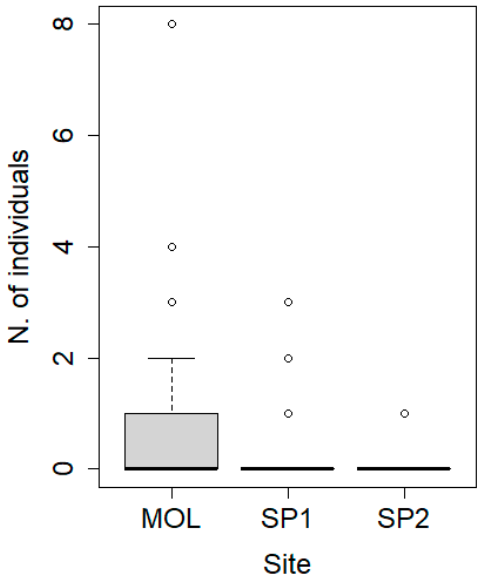
Figure 3. Box-plot of the cumulative abundance of individuals of the mottled grouper censused per study site considering both years (2017 and 2018). Number of replicates (strip transects) per site: 88 at MOL, 64 at SP1 and 52 at SP2. Mottled grouper density was significantly different at MOL compared to the other sites (Kruskal–Wallis chi-squared = 14.41, df = 2, p = 0.0007). In summer 2018, the recorded size distributions of M. rubra differed among the three study sites, with the largest individuals recorded at MOL. Individual total lengths (TL) ranged from 45 to 85 cm at MOL and from 55 to 65 cm at SP1 and SP2 (Figure 4).